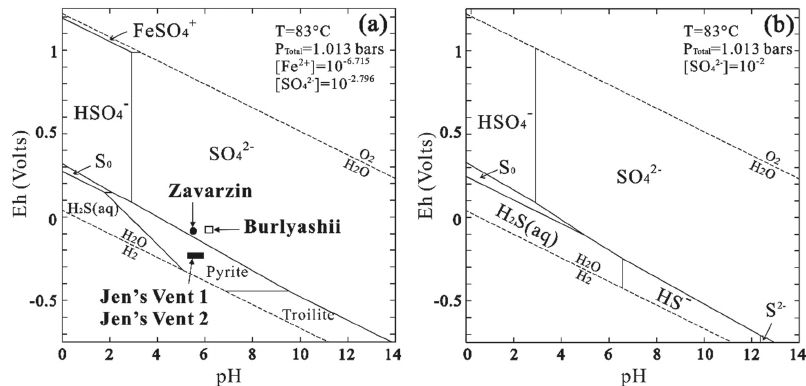
Figure 3. Eh-pH diagrams calculated using Geochemist’s Workbench illustrating [69]: ( a ) Eh, pH, temperature and estimated ion concentrations in Kamchatka hot springs Jen’s Vent 1, Vent 2, Zavarzin and Burlyashii (83 ◦ C, Activities: Fe 2 + = 10 − 6.715 , SO 42 − = 10 − 2.796 ); ( b ) The thermodynamic stability of elemental sulfur under the current geochemical conditions (83 ◦ C, Activity: SO 42 − = 10 − 2 ).